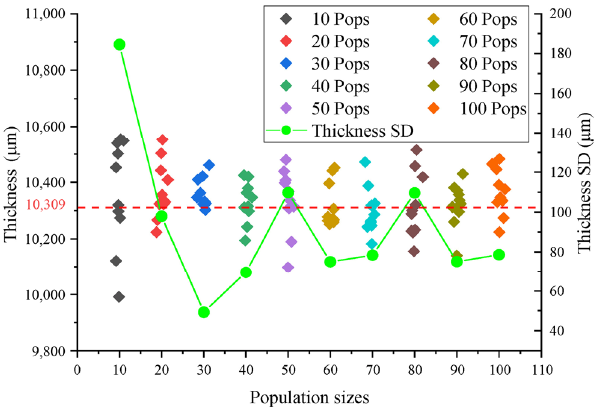
Fig. 17 Effect of different population sizes on thickness inversion